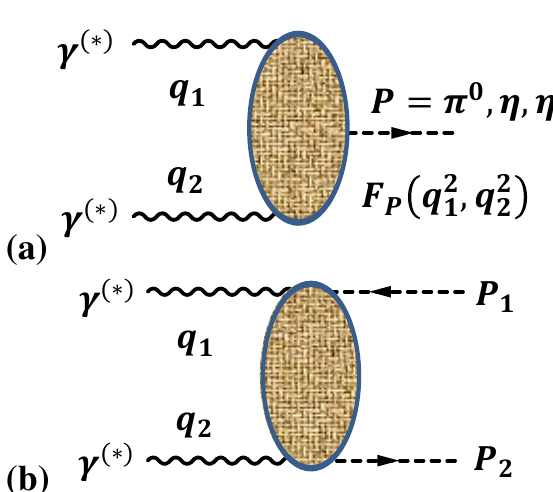
𝑷𝑷 𝟐𝟐 Figure 1. (a): P γ ∗ γ ∗ vertex – a neutral pseudoscalar meson tran-